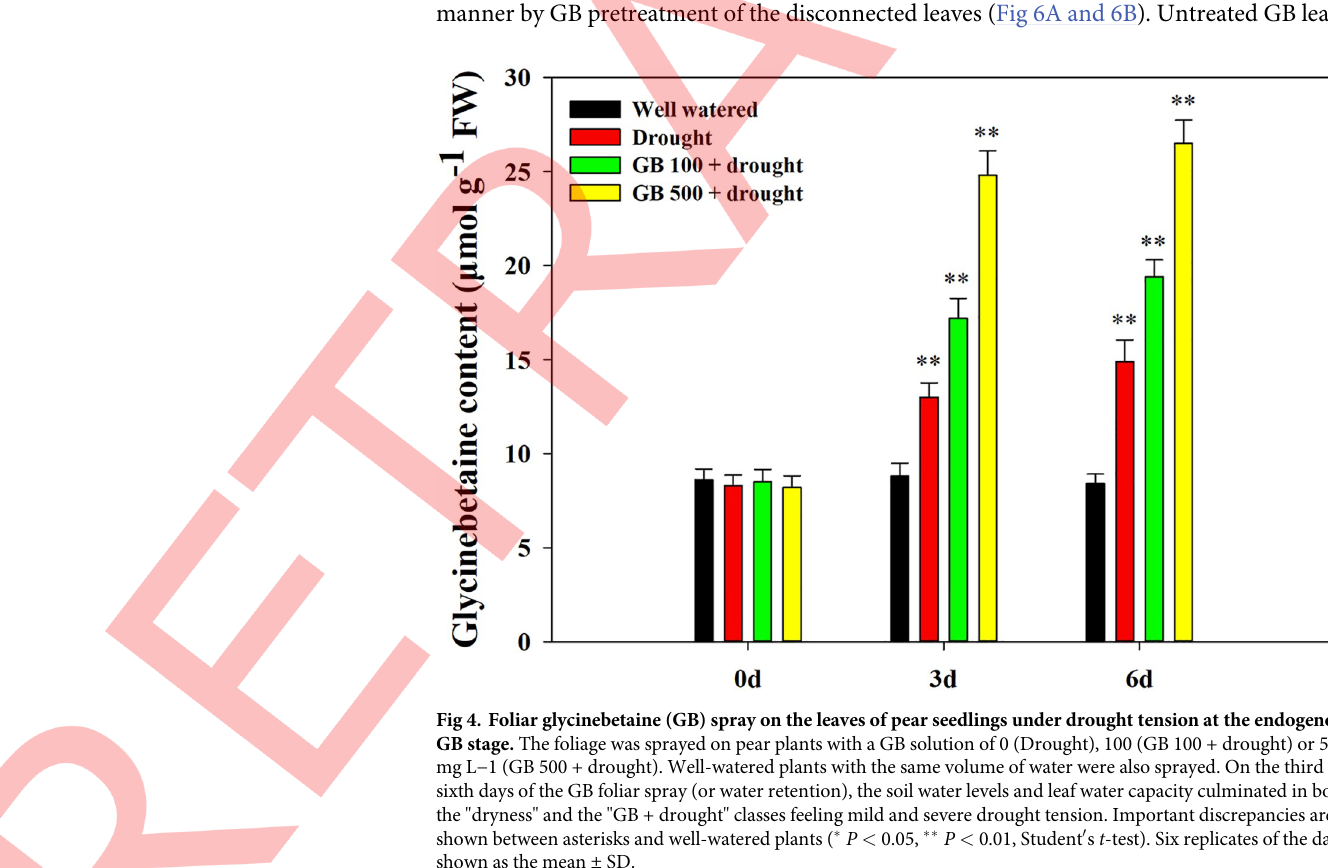
Fig 4. Foliar glycinebetaine (GB) spray on the leaves of pear seedlings under drought tension at the endogenous GB stage. The foliage was sprayed on pear plants with a GB solution of 0 (Drought), 100 (GB 100 + drought) or 500 mg L − 1 (GB 500 + drought). Well-watered plants with the same volume of water were also sprayed. On the third and sixth days of the GB foliar spray (or water retention), the soil water levels and leaf water capacity culminated in both the "dryness" and the "GB + drought" classes feeling mild and severe drought tension. Important discrepancies are shown between asterisks and well-watered plants ( � P < 0.05, �� P < 0.01, Student 0 s t -test). Six replicates of the data are shown as the mean ±